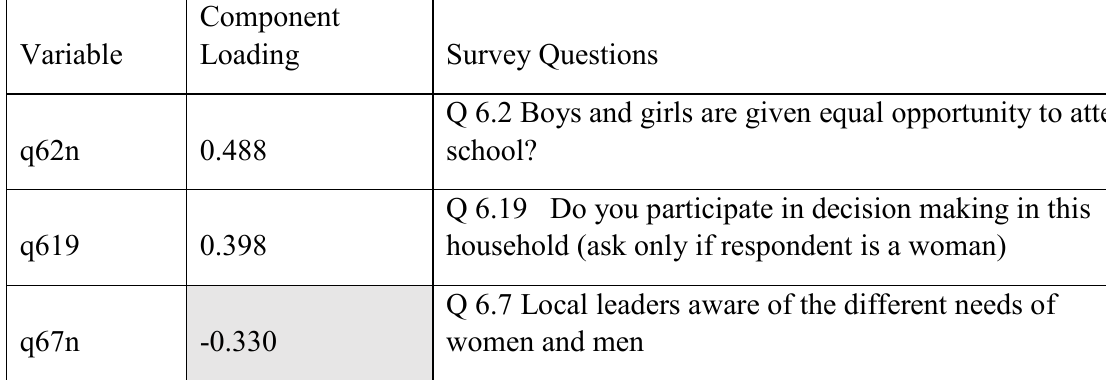
Table 1.54: Variables defining Transformative Resilience PC8 Variable